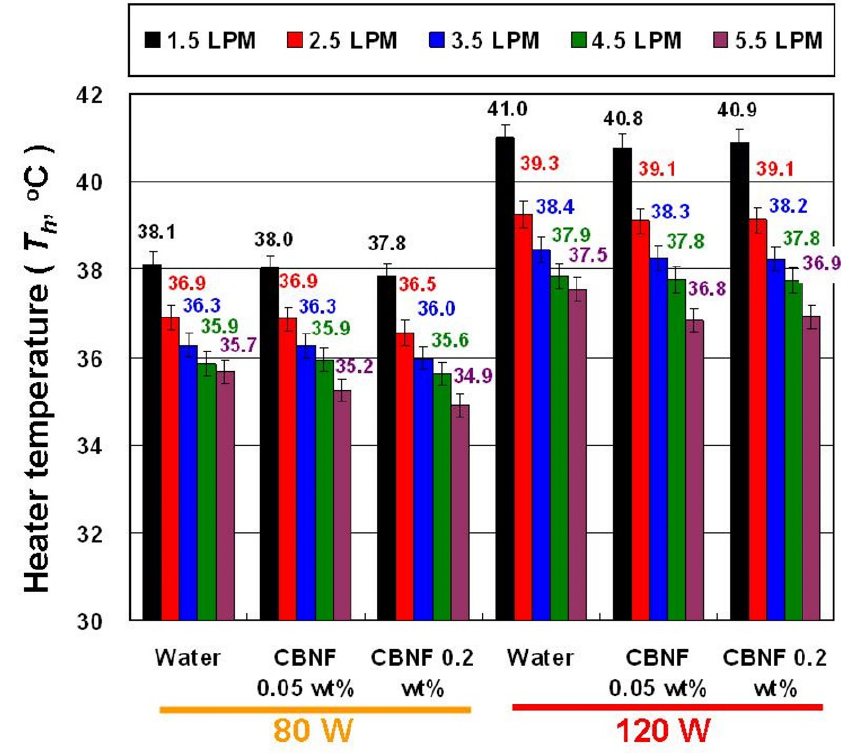
Figure 7. The T h of test samples for THE at various experimental parameters. The ∆ T h-w (temperature difference between heater and working fluid) of test sample for THE at various experimental parameters is presented in Figure 8, according to which, the ∆ T h-w of CBNFs is smaller than that of water under the same flow rate and heating power, indicating that using CBNF as the working fluid in THE can obtain a higher HTC (refer to Equation (1)). In terms of the average value of the overall flow range, the ∆ T h-w of 0.05 wt% and 0.2 wt% CBNF at a heating power of 80 W is 1.97% and 3.70% lower than that of water, respectively, while the ∆ T h-w of 0.05 wt% and 0.2 wt% CBNF at a heating power of 120 W is 2.77% and 2.34% lower than that of water,